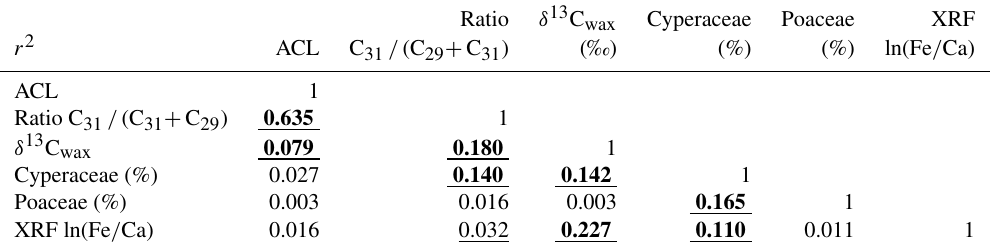
Table 1. Correlation coefficients calculated with PAST (Hammer et al., 2001). Significant correlations are underlined (95%) or bold and underlined (99%). Average chain length (ACL), ratio of concentrations of C 31 / (C 31 + C 29 ) and stable carbon isotope composition of the C 31 n -alkane ( δ 13 C wax ) after Castañeda et al. (2016b). Cyperaceae and Poaceae pollen percentages (of total pollen and spores) after Dupont et al. (2011b) and this study. ln(Fe / Ca) data are after Caley et al. (2018c).